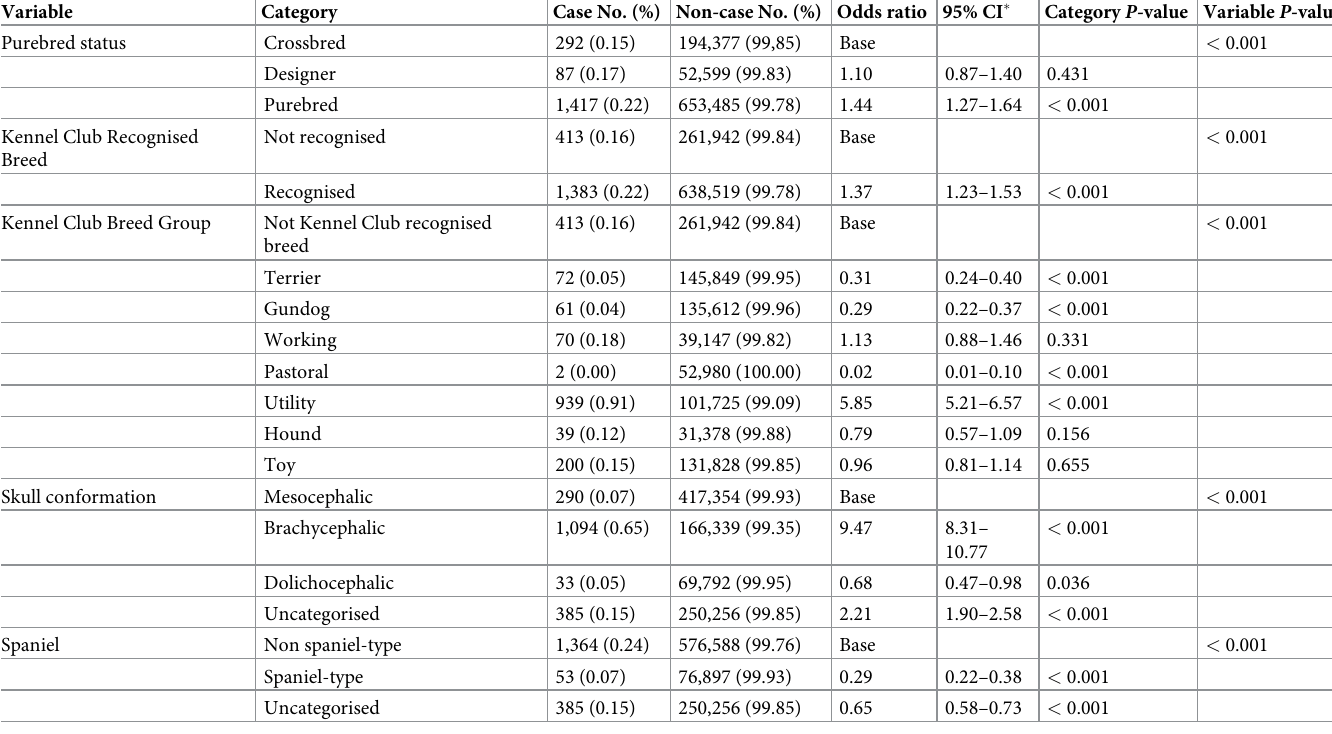
Table 2. Descriptive and univariable logistic regression results for breed-derived risk factors for prolapsed nictitating membrane gland (PNMG) during 2016 in dogs under primary veterinary care in the VetCompass ™ Programme in the UK. Column percentages shown in